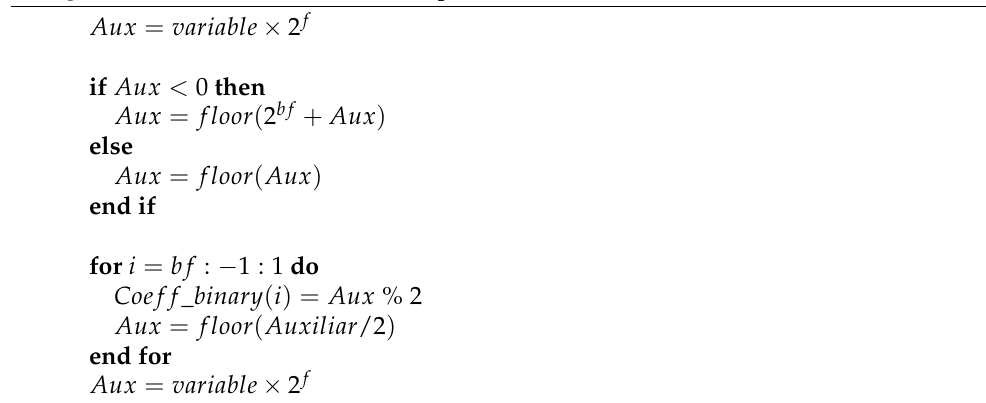
Algorithm 1: Binarization of a fixed-point